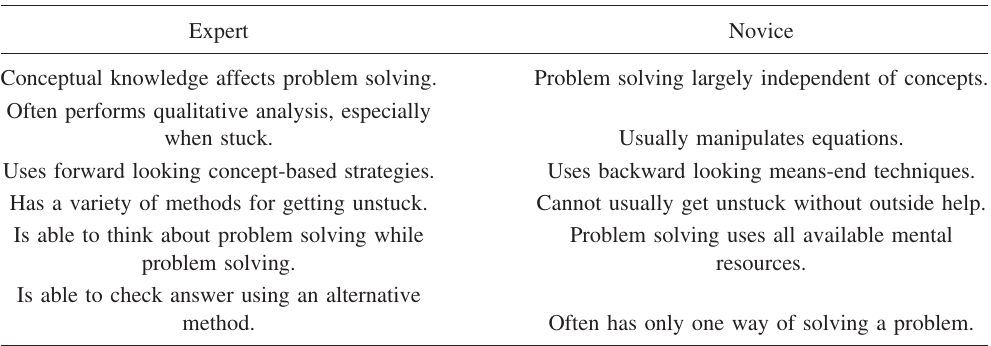
TABLE I. Differences in problem solving between experts and novices (cid:1) Ref. 12 (cid:2) . Expert Novice Conceptual knowledge affects problem solving. Problem solving largely independent of